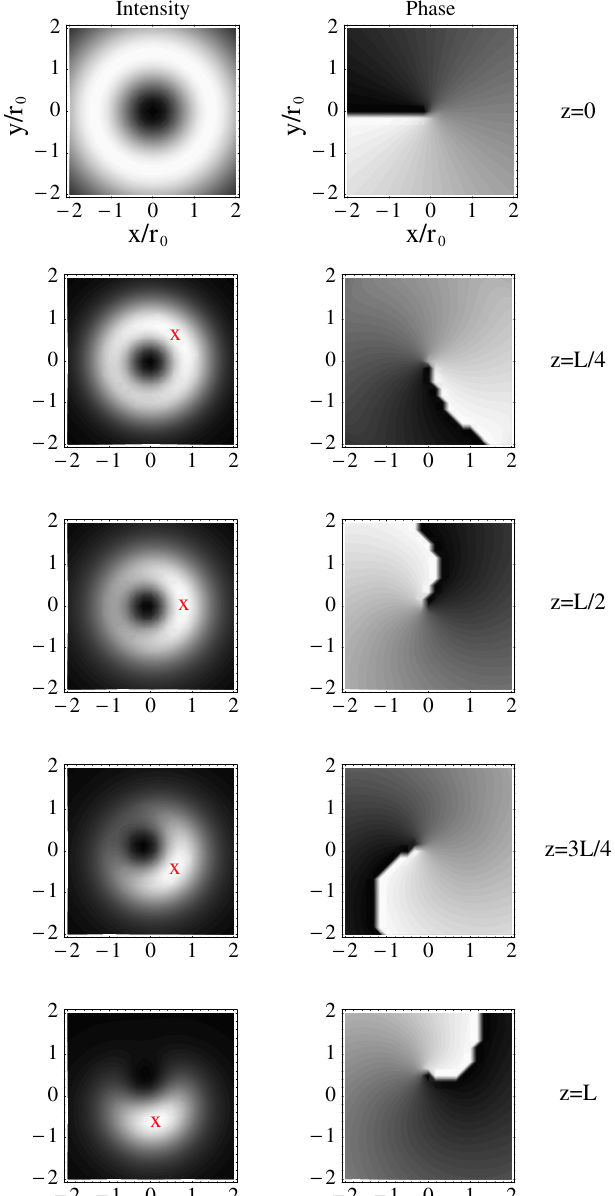
FIG. 3. (Color) Intensity and phase along the undulator for an l (cid:3) 1 seed on a cold beam, prebunched at the fundamental. The fundamental mode grows faster than the OAM mode, appearing as a bright spot (red x) on the annular intensity pattern and eventually pushing the phase singularity, located at the field null, off to the side. The different effective phase velocities of the modes is manifest in the rotation of the bright spot along the undulator.